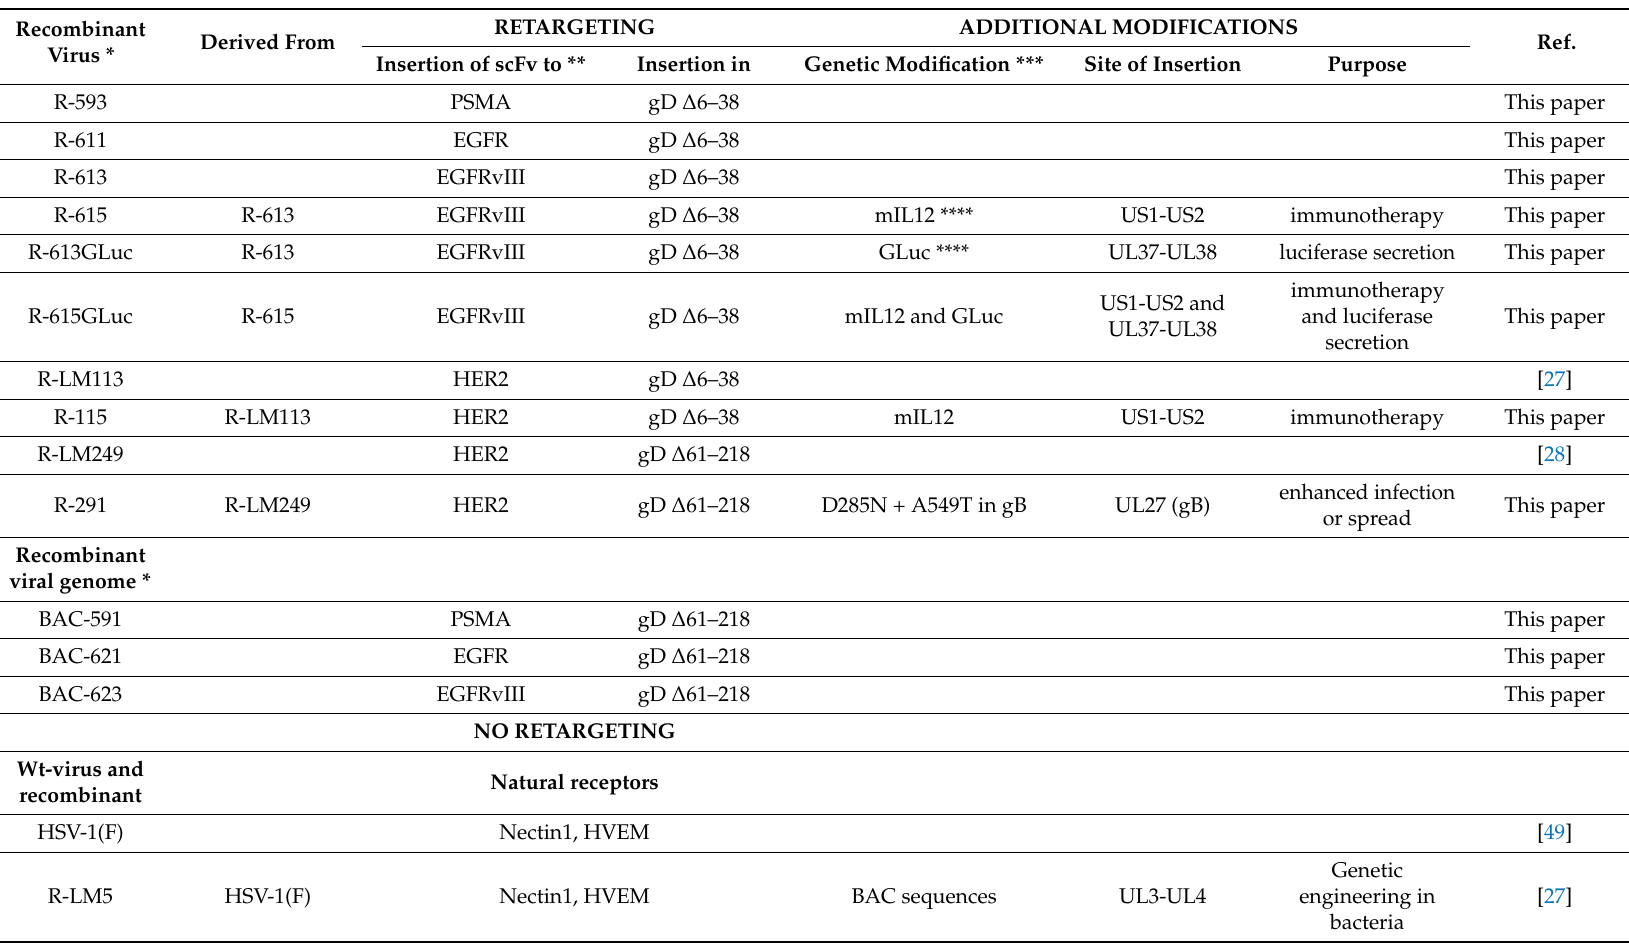
Table 1. Key features of wt and recombinant (R) viruses, of recombinant viral genomes (BAC), and of the parental viruses employed in this paper.